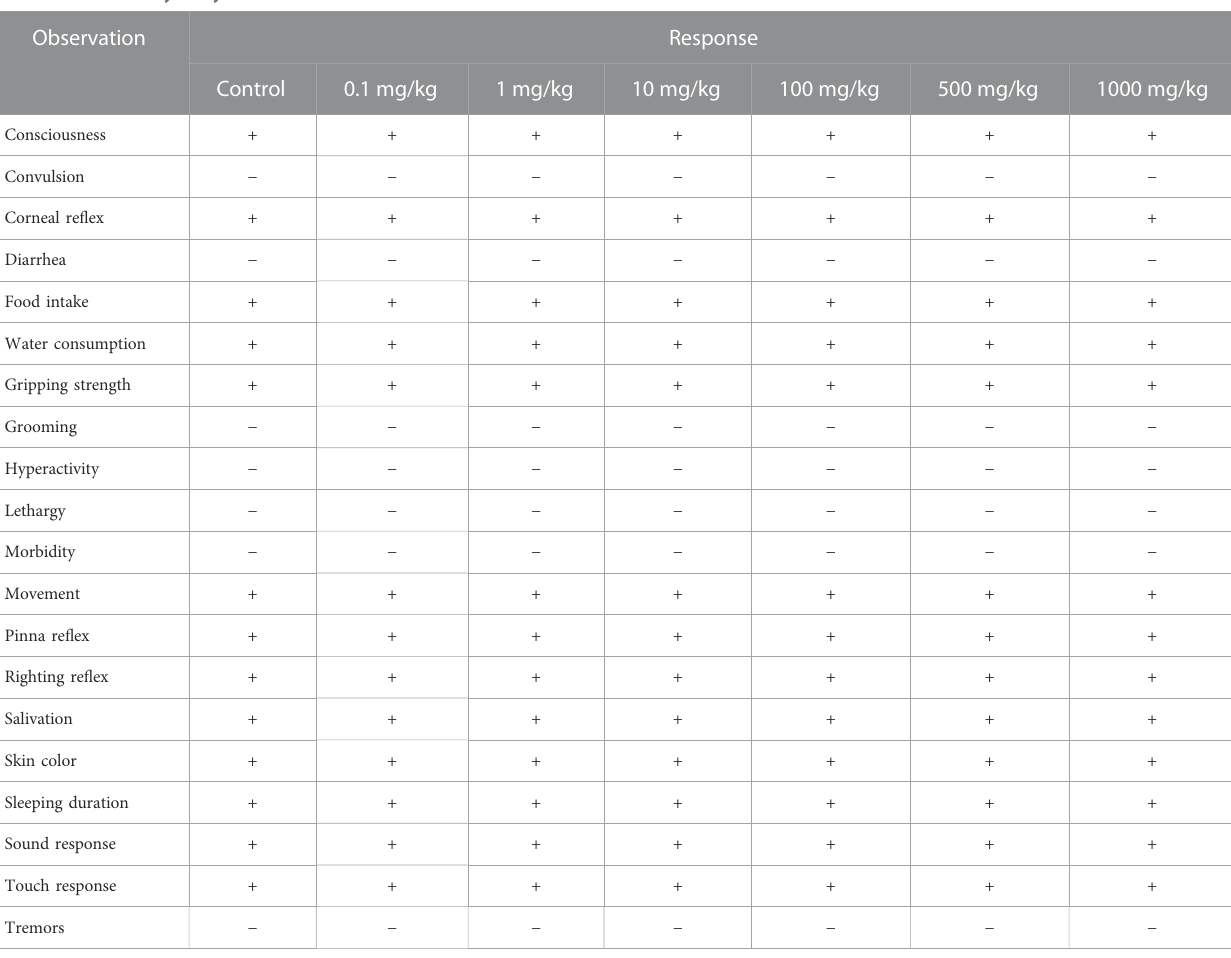
TABLE 6 Acute toxicity study of SBL in mice.